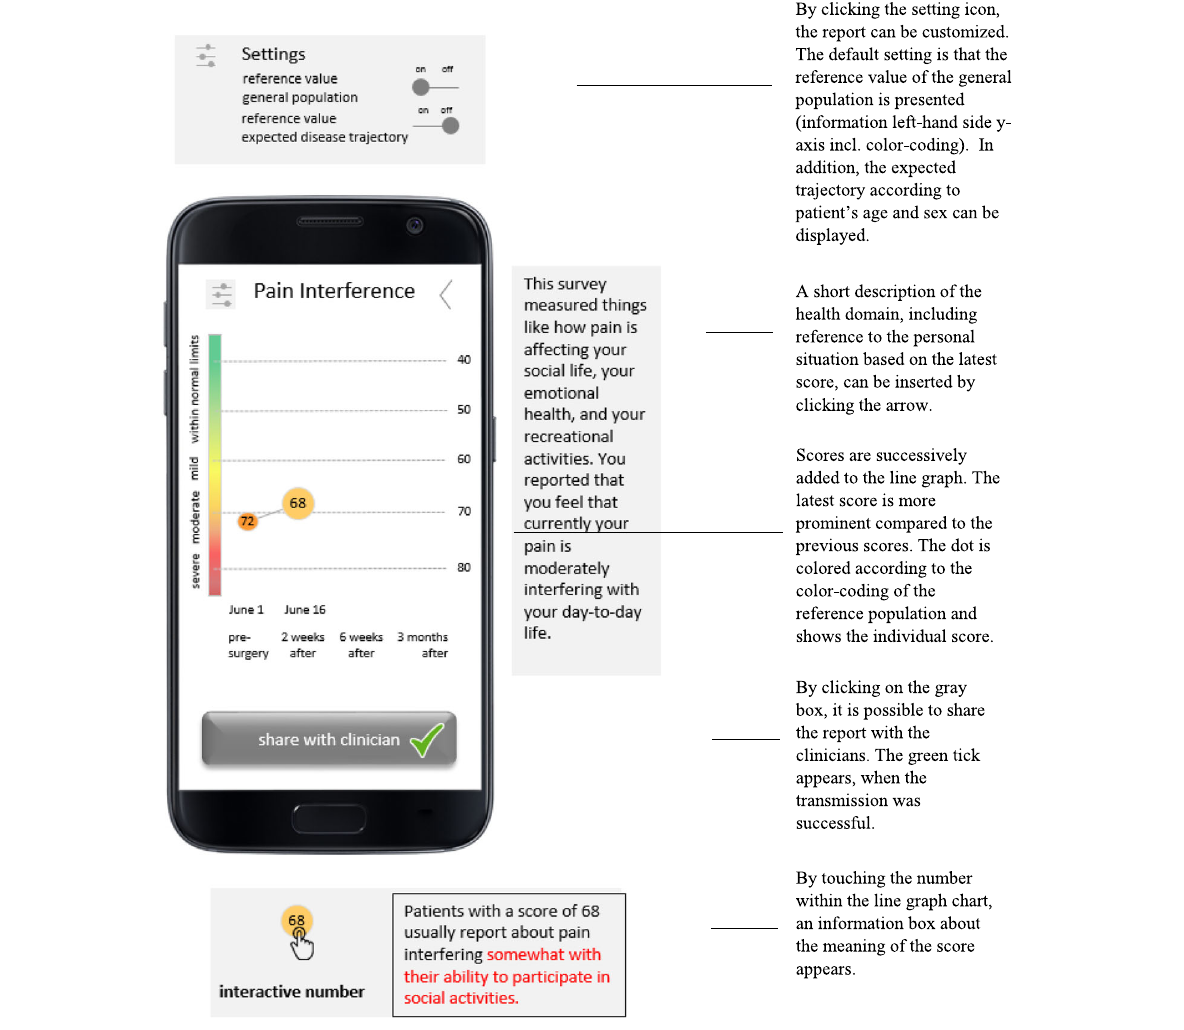
Fig. 3 Final graphical display of the PRO feedback reports for the health domain of Pain